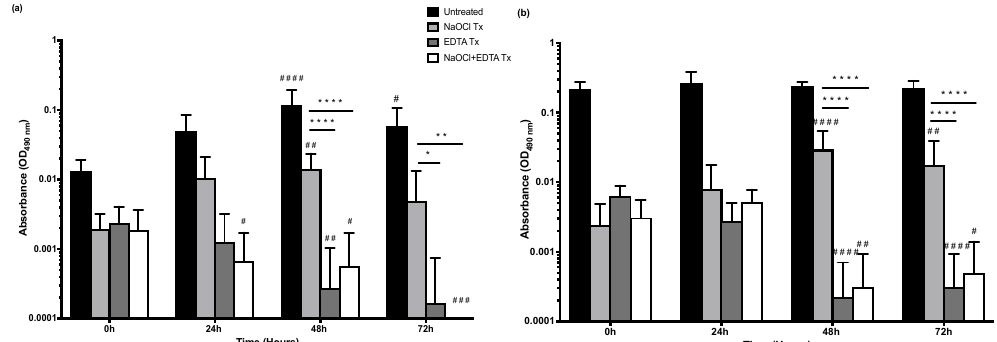
Figure 5. The e ff ect of the three treatment conditions: NaOCl, ethylenediaminetetraacetic acid (EDTA) and NaOCl + EDTA on pre-formed 24 h biofilms viability in relation to untreated biofilms. Biofilms were treated for 5 min and reincubated with fresh RPMI. XTT readings were taken at 0, 24, 48 72 h. Values were plotted as log 10 on the Y axis. ( a ) absorbance values for LBF ( b ) absorbance values for HBF. Statistical significance between the three treatment conditions at 48, and 72 h was presented as * p < 0.05, ** p < 0.01 and **** p < 0.0001. Whereas the significant di ff erence in relation to untreated biofilms of the same treatment condition over time was presented as # p < 0.05, ## p < 0.01, ### p < 0.001 and #### p < 0.0001.